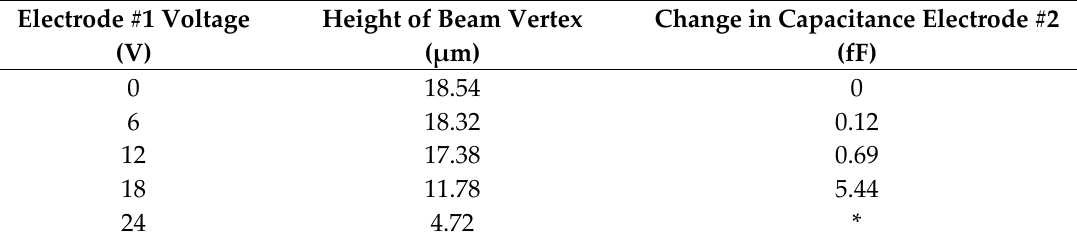
Table 1. This table shows beam vertical displacement and change in individual electrode capacitance based when a voltage is applied to electrode #1. Data was calculated using Coventorware ® software under license to Air Force Institute of Technology.